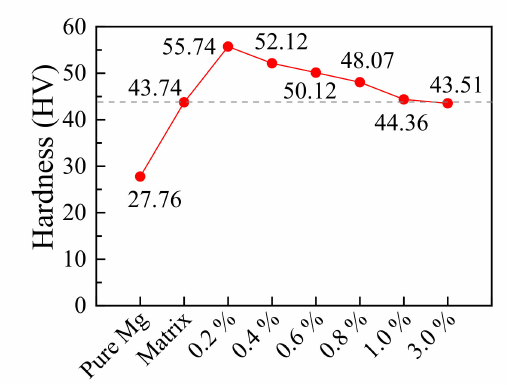
Figure 10. Hardness curve of the samples with different Ce contents.